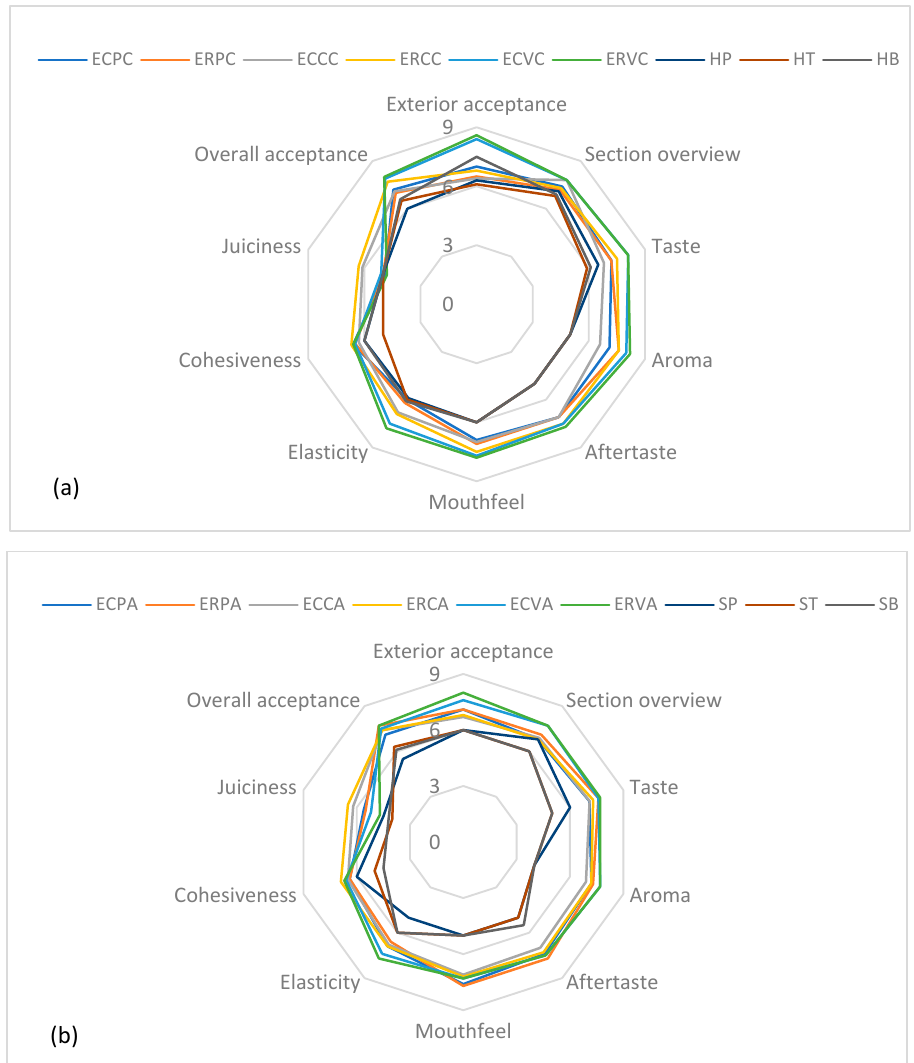
Figure 3. Comparative diagram of the sensory attributes specific to meatballs, obtained by ( a )—hot air convection and ( b )—steam convection; ECPC and ECPA are pork meatballs enriched with wild thyme aqueous extract; ERPC and ERPA are pork meatballs enriched with lemon balm aqueous extract; ERCC and ERCA are turkey meatballs enriched with lemon balm aqueous extract; ECVC and ECVA are beef meatballs enriched with wild thyme aqueous extract; ERVC and ERVA are beef meatballs enriched with lemon balm aqueous extract; HP, HT and HB are pork, turkey, and beef control meatballs, processed by hot air convection. SP, ST, and SB are pork, turkey, and beef control meatballs thermally treated by steam convection.